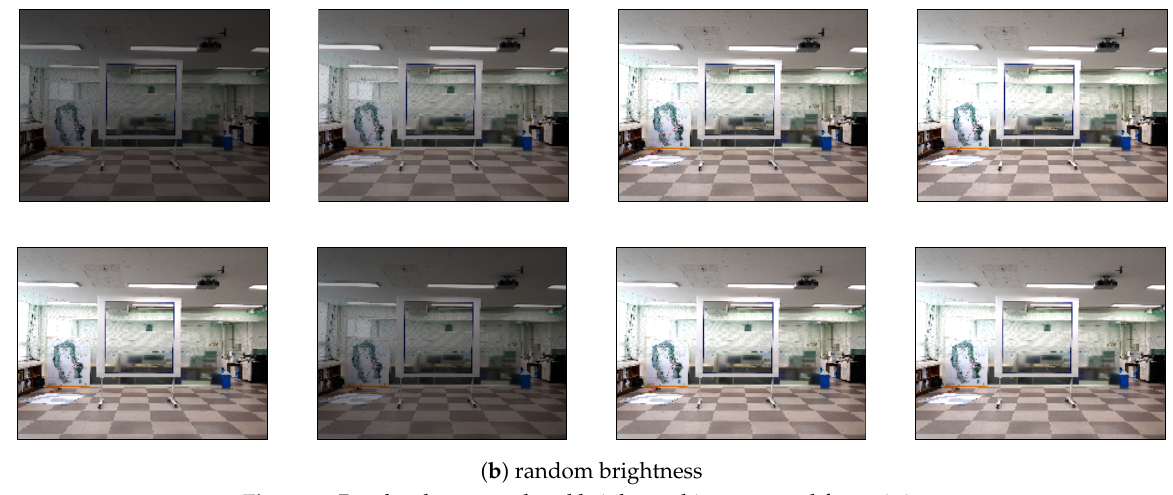
Figure 5. Randomly cropped and brightened images used for training.